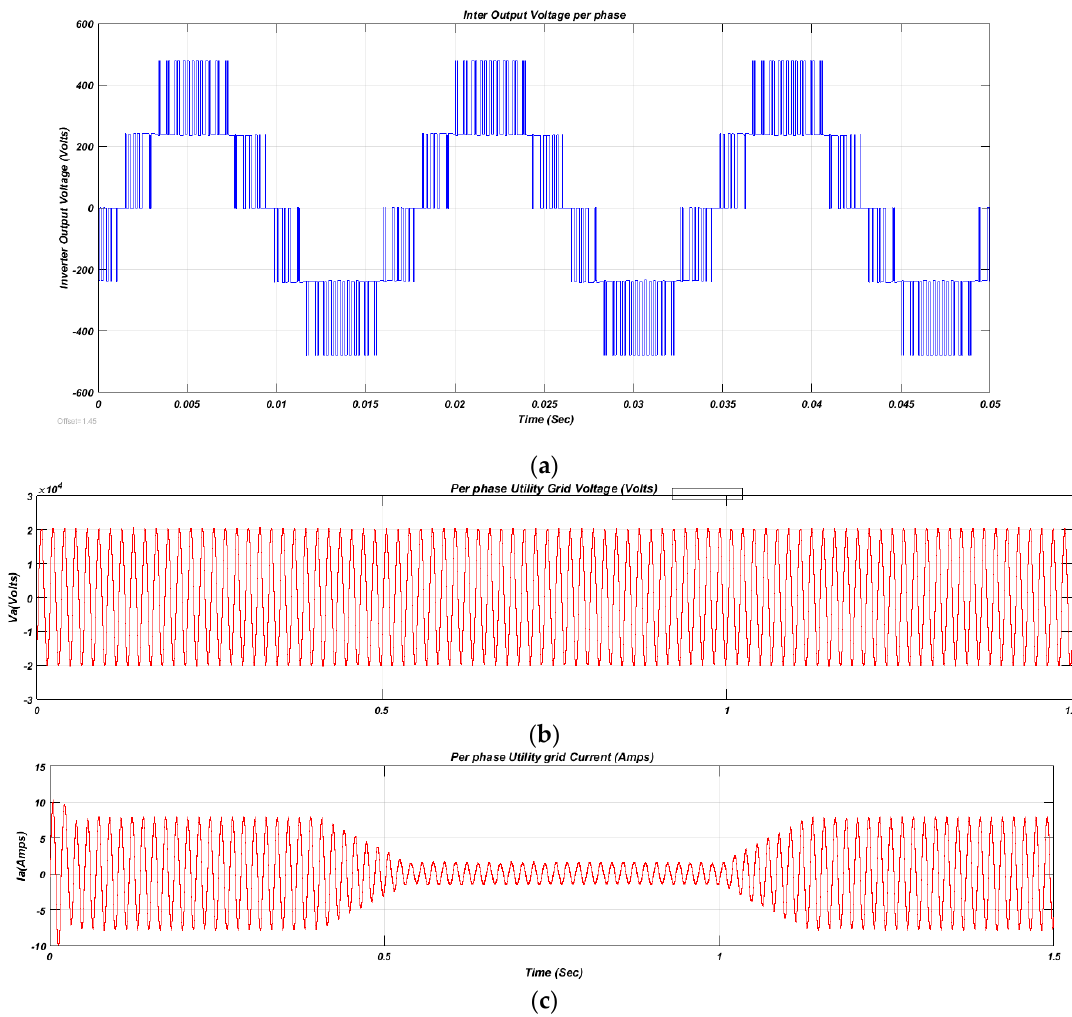
Figure 5. Utility grid results: ( a ) power output, ( b ) voltage generated from grid for three phases, ( c ) current generated from grid for three phases.